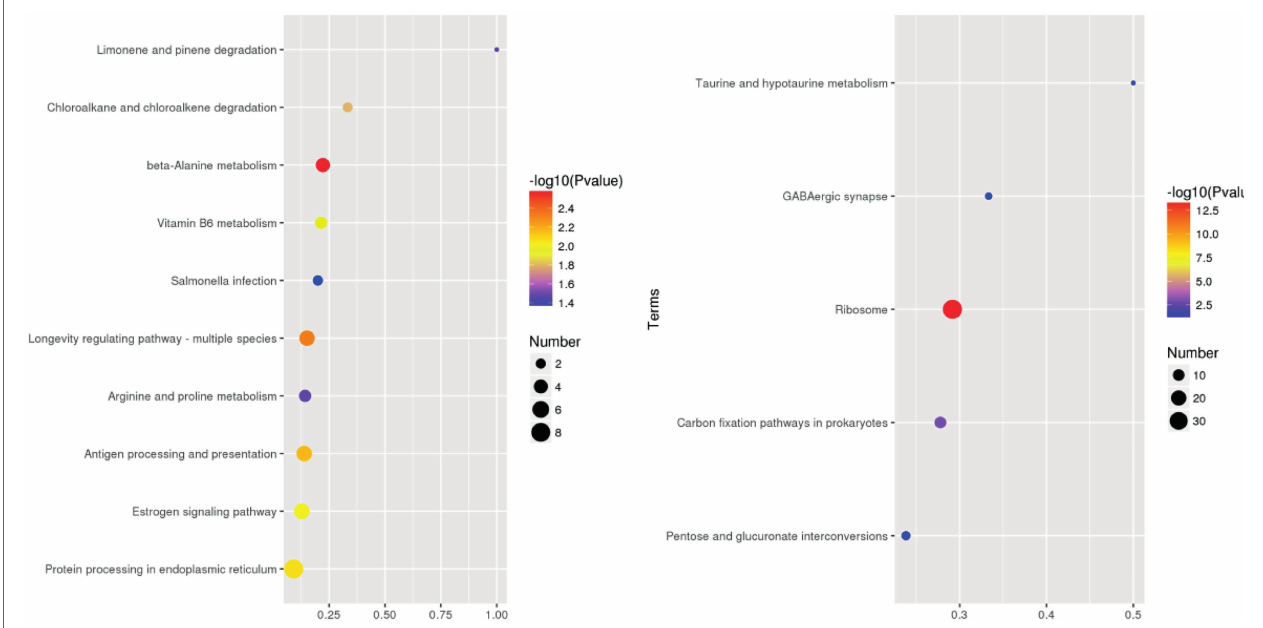
FIGURE 4 | KEGG pathway enrichement analysis of the DEPs in Bai5 and Vao-9.